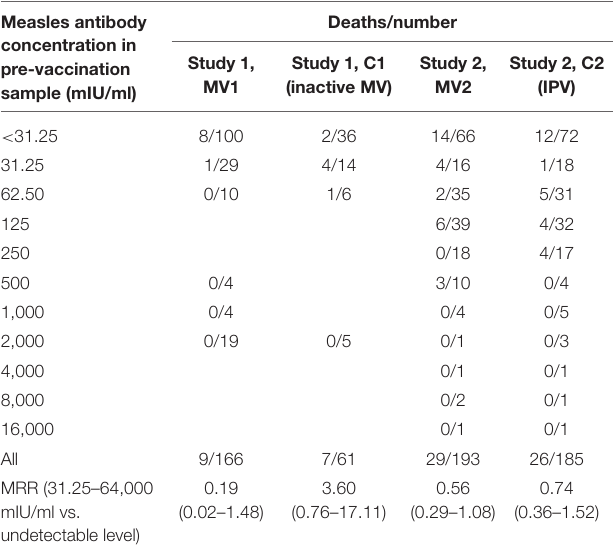
TABLE 1 | Mortality in relation to the presence of measles antibody at the time of measles vaccination or control vaccination. Measles antibody concentration in pre-vaccination sample